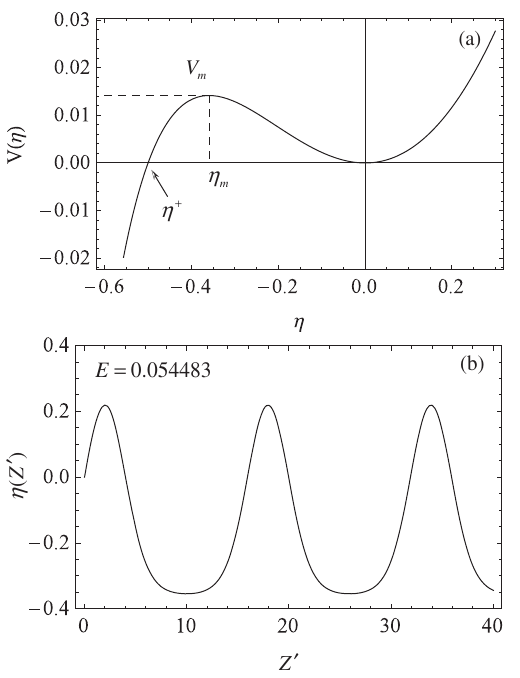
FIG. 15. Plots are shown for (a) V ð η Þ versus η , and (b) η ð Z 0 Þ versus Z 0 , obtained from Eq. (94) for M 2 ¼ 0 . 5 , η 0 ð 0 Þ ¼ 0 . 1863 , E ¼ ð 1 = 2 Þ½ η 0 ð 0 Þ(cid:4) 2 ¼ 0 . 054883 , η þ ¼ − 0 . 5 , η 0 . 014 . V ð η m Þ ¼